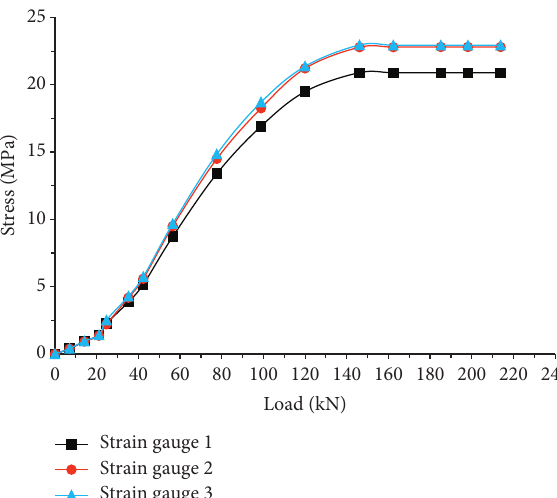
Figure 12: Stress/load curves at different measuring points in the compressive zone of the concrete specimen along the short-span direction.